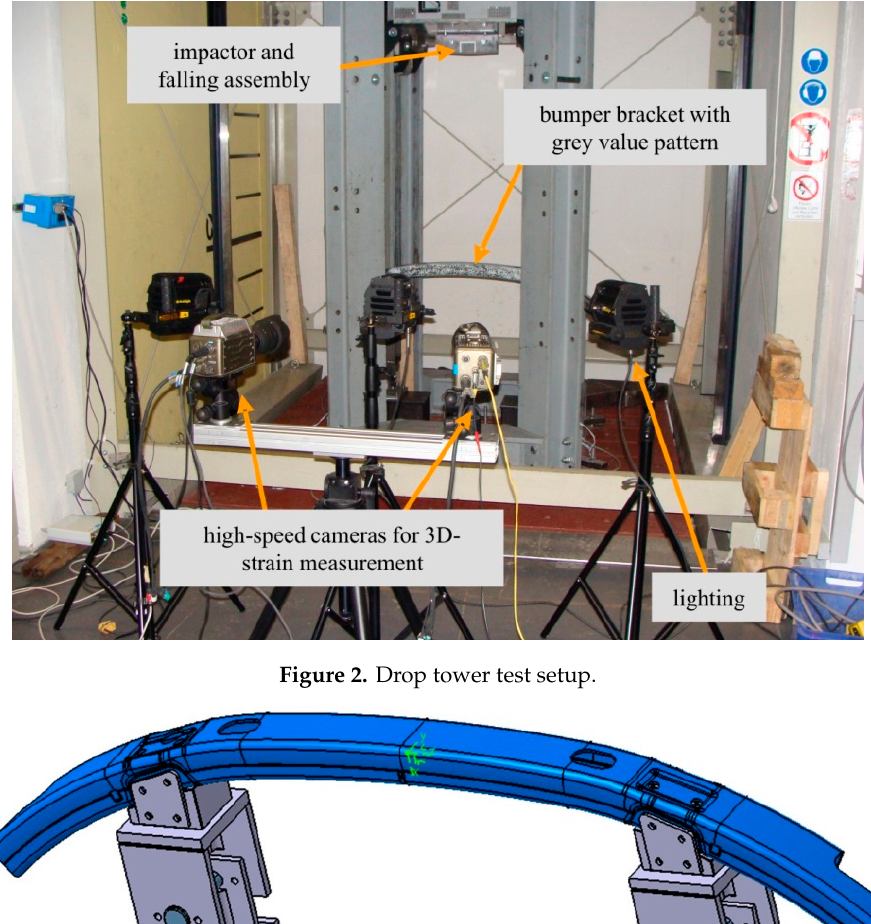
Figure 2. Drop tower test setup.